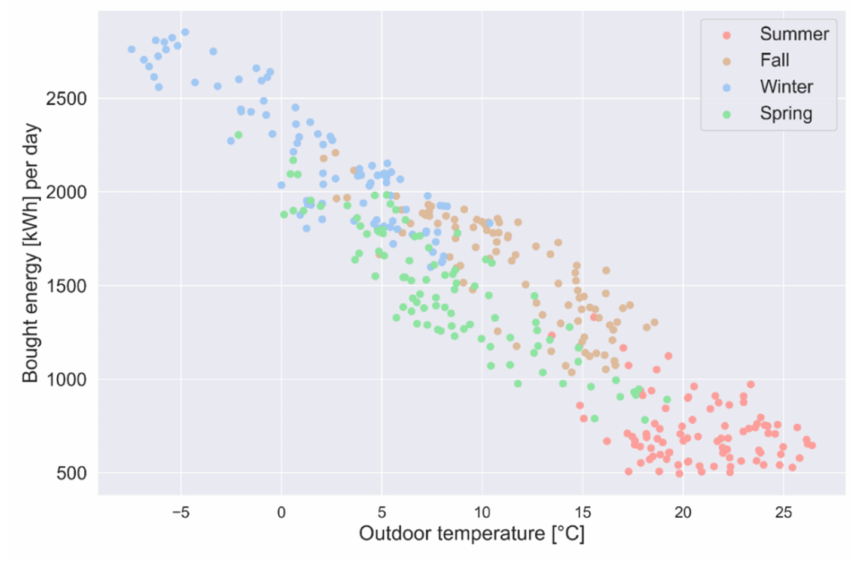
Figure 10. Energy signature: daily bought electricity versus average of outdoor